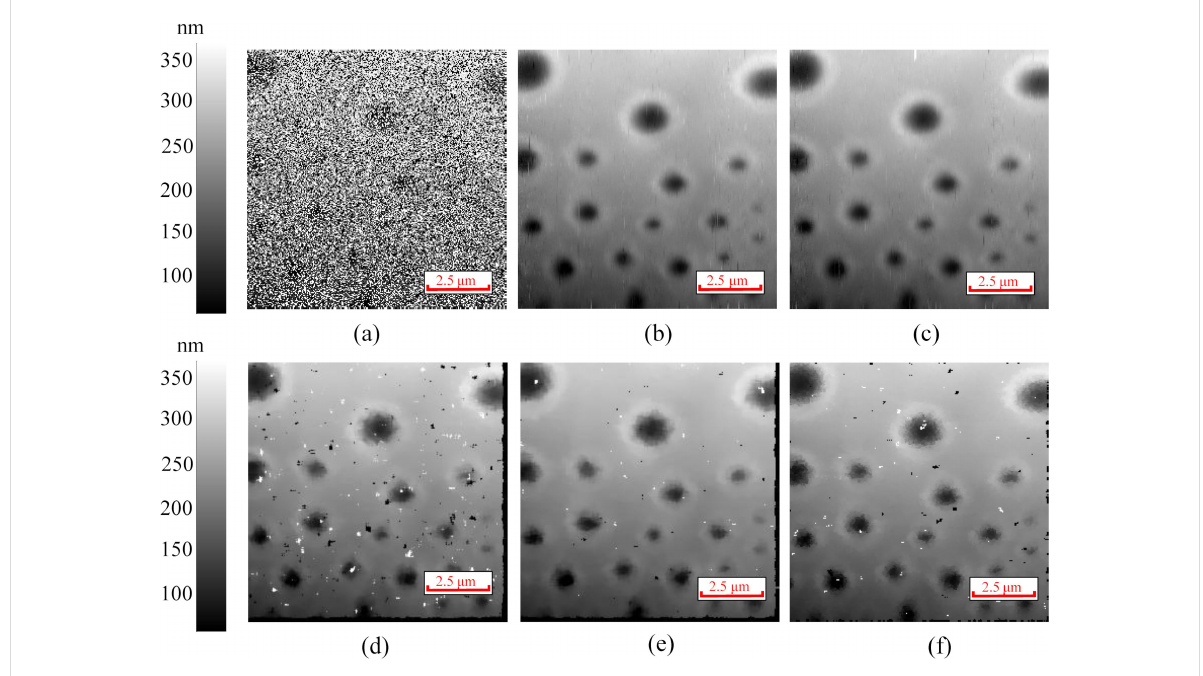
Figure 7: (a) AFM image with added noise of high density. (b) Denoised image obtained by the interval-BCS denoising. (c) Denoised image obtained by the self-comparison-BCS denoising. (d) Denoised image obtained by the median filter with a filter window of 6 × 6 pixels. (e) Denoised image ob- tained by the median filter with a filter window of 7 × 7 pixels. (f) Denoised image obtained by the adaptive median filter with a maximum window size of 7 × 7 pixels and a minimum window size of 3 × 3 pixels.